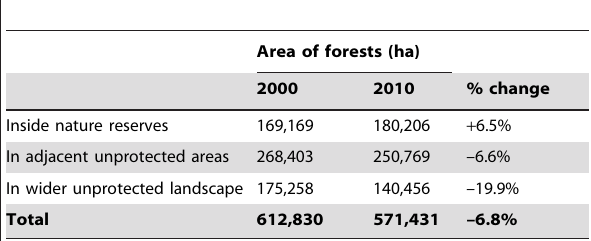
Table 1. Changes in tropical forests across Hainan Island.